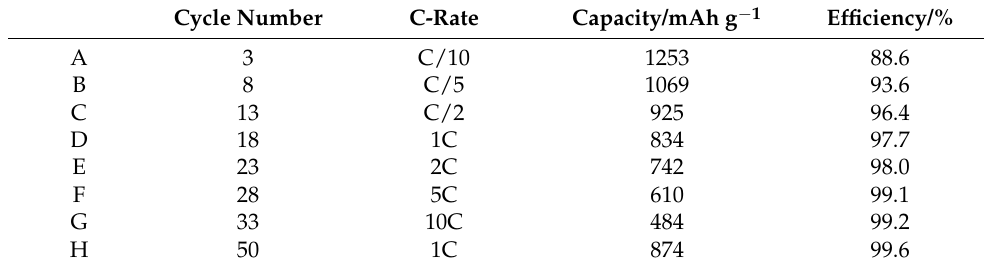
Table 1. Specific capacities and efficiencies of the Fe 3 O 4 /rGO at different C-rates, as from Figure 7a .